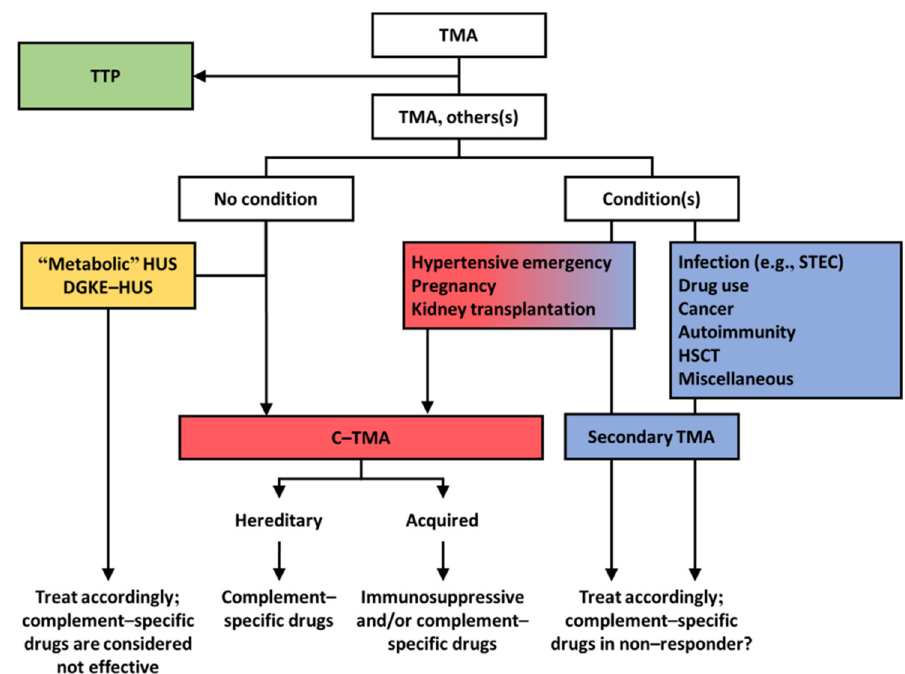
Figure 3. Pragmatic approach to diagnosis and treatment of TMA. Patients should be tested for the enzymatic activity of ADAMTS13 (i.e., >10% excludes thrombotic thrombocytopenic purpura (TTP)). Patients with a normal activity of ADAMTS13 should be screened for coexisting conditions. DGKE, diacylglycerol kinase epsilon. HSCT, hematopoietic stem cell transplantation. HUS, hemolytic uremic syndrome. STEC, Shiga toxin–producing E. coli .